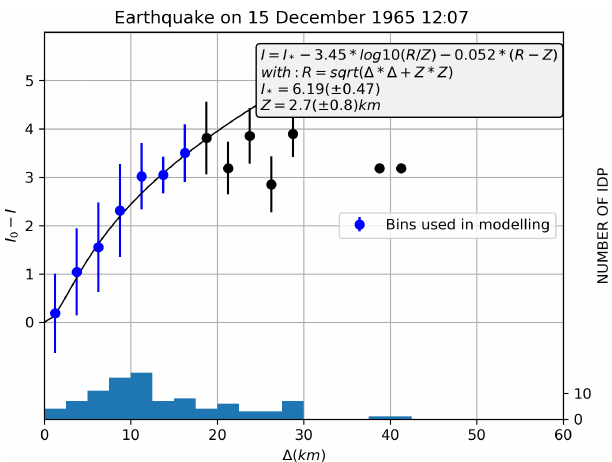
Figure 7. Evaluation of focal depth and epicentral intensity for the 15 December 1965 Strépy-Bracquegnies earthquake. The first seven distance bins (blue) are used in the modelling. Similar diagrams are provided in the Atlas for the 13 other earthquakes for which this method was